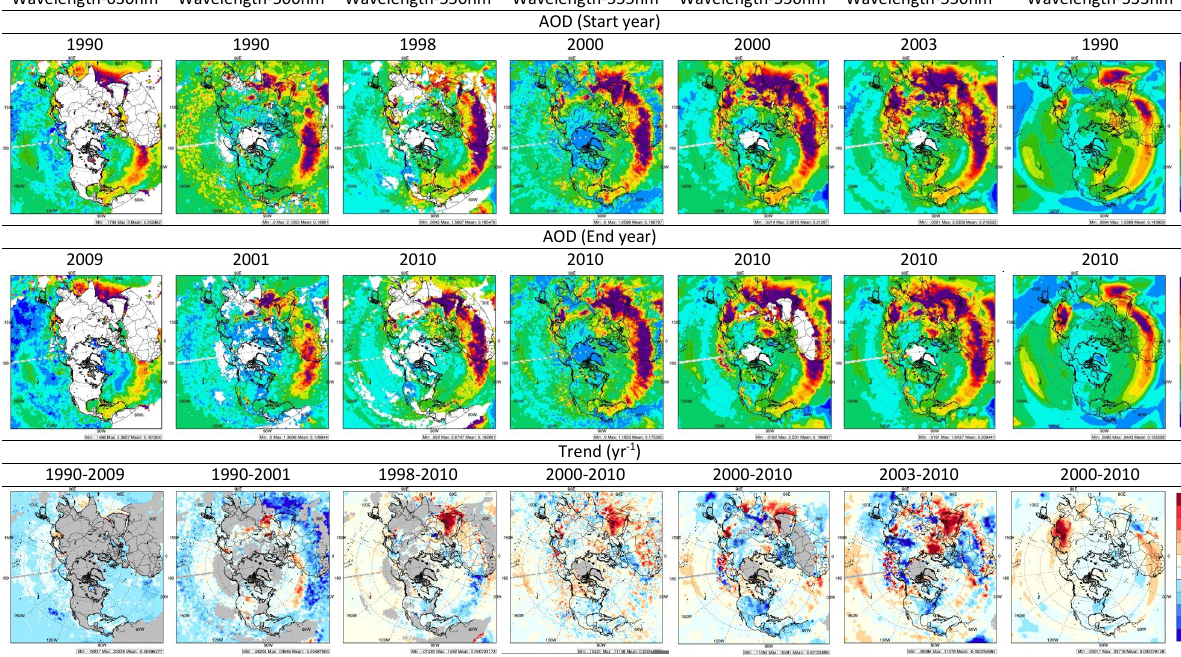
Figure 2. Spatial distribution of summertime AOD and its trend from satellite retrievals and the WRF-CMAQ